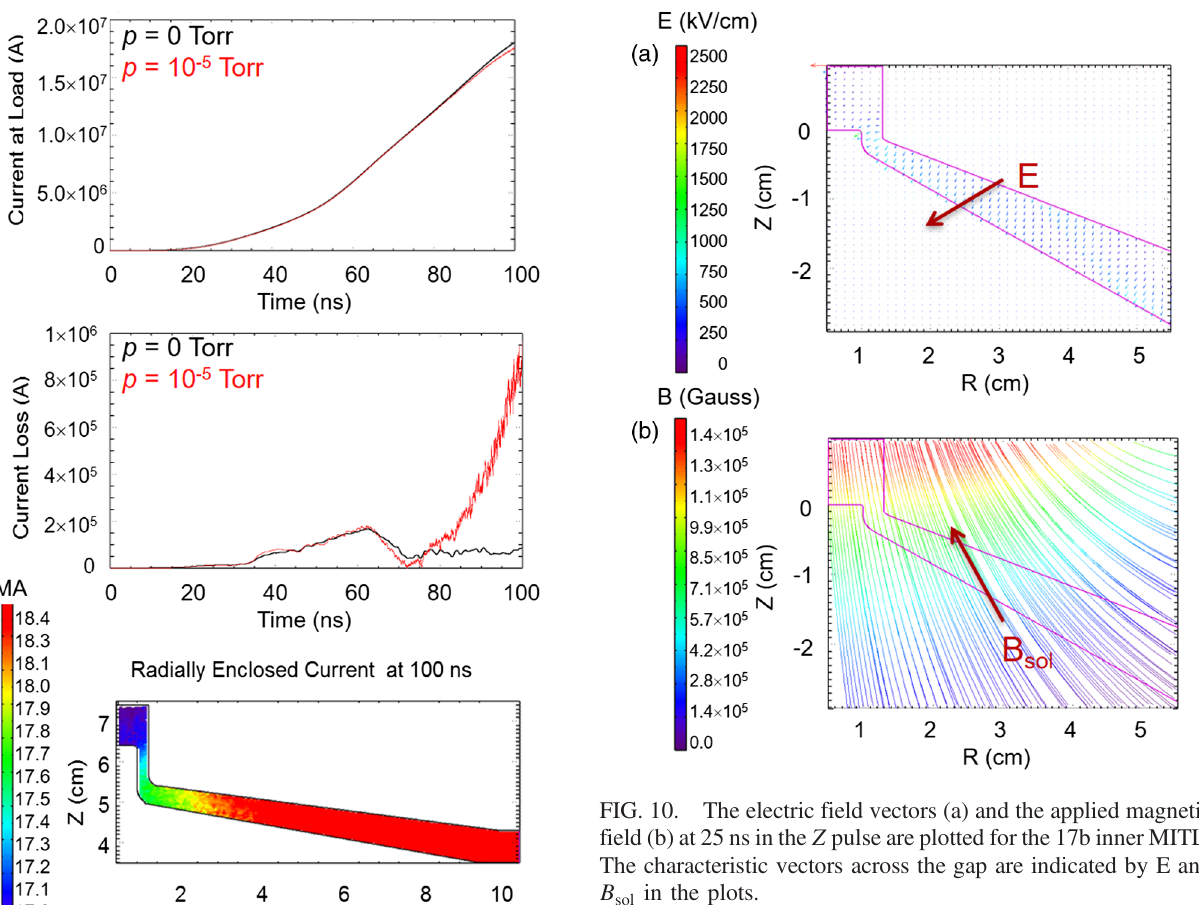
¼ 1 has 8 × 10 15 ML